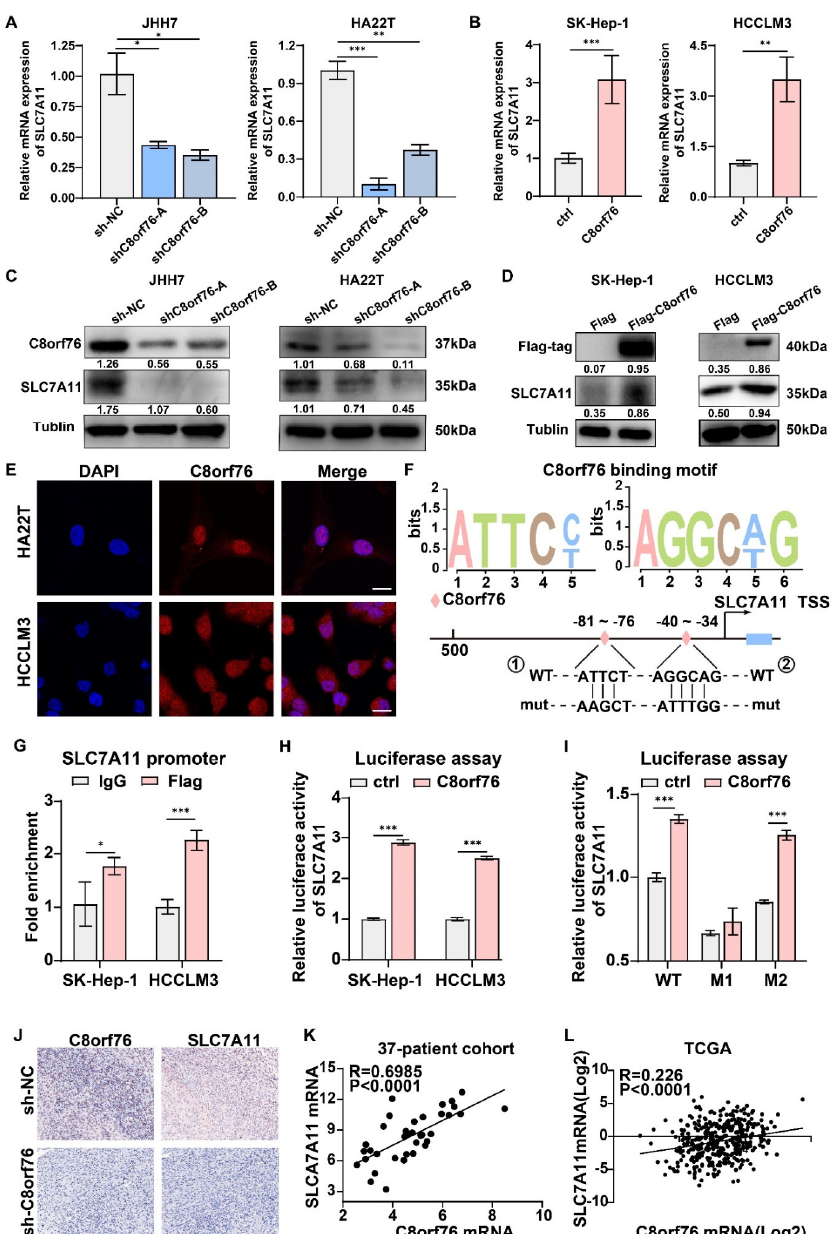
Figure 8. C8orf76 activates SLC7A11 at the transcriptional level through directly binding to the promoter of SLC7A11. ( A , B ) SLC7A11 was analyzed using qPCR in HCC cells stably knocking down or overexpression of C8orf76 (n = 3). ( C , D ) The protein expression of SLC7A11 was analyzed by Western blot after C8orf76 knockdown or overexpression in HCC cells. ( E ) The localization of C8orf76 was viewed by laser scanning confocal microscope in both HA22T and HCCLM3 cells. Scale bars represent 20 µ m. ( F ) Two potential C8orf76 DNA − binding motifs in the promoter region of SLC7A11. ( G ) CHIP-qPCR analysis was performed to determine the relation between C8orf76 and the promoter of SLC7A11. ( H ) The relative activities of the SLC7A11 promoter after transfection of C8orf76 and vector. ( I ) The relative activities of the SLC7A11 promoter and the mutant promoter after transfection of C8orf76 and vector. ( J ) C8orf76 and SLC7A11 protein expression in subcutaneous xenografts detected by immunohistochemistry. Scale bars represent 50 µ m. ( K , L ) C8orf76 mRNA level is positively correlated with SLC7A11 mRNA levels in 37 patients and the TCGA dataset. Data were presented as mean +SD. * p < 0.05; ** p < 0.01; *** p < 0.001; ns, not significant. WT, wild type; M1, mutated C8orf76 recognition site 1; M2, mutated C8orf76 recognition site